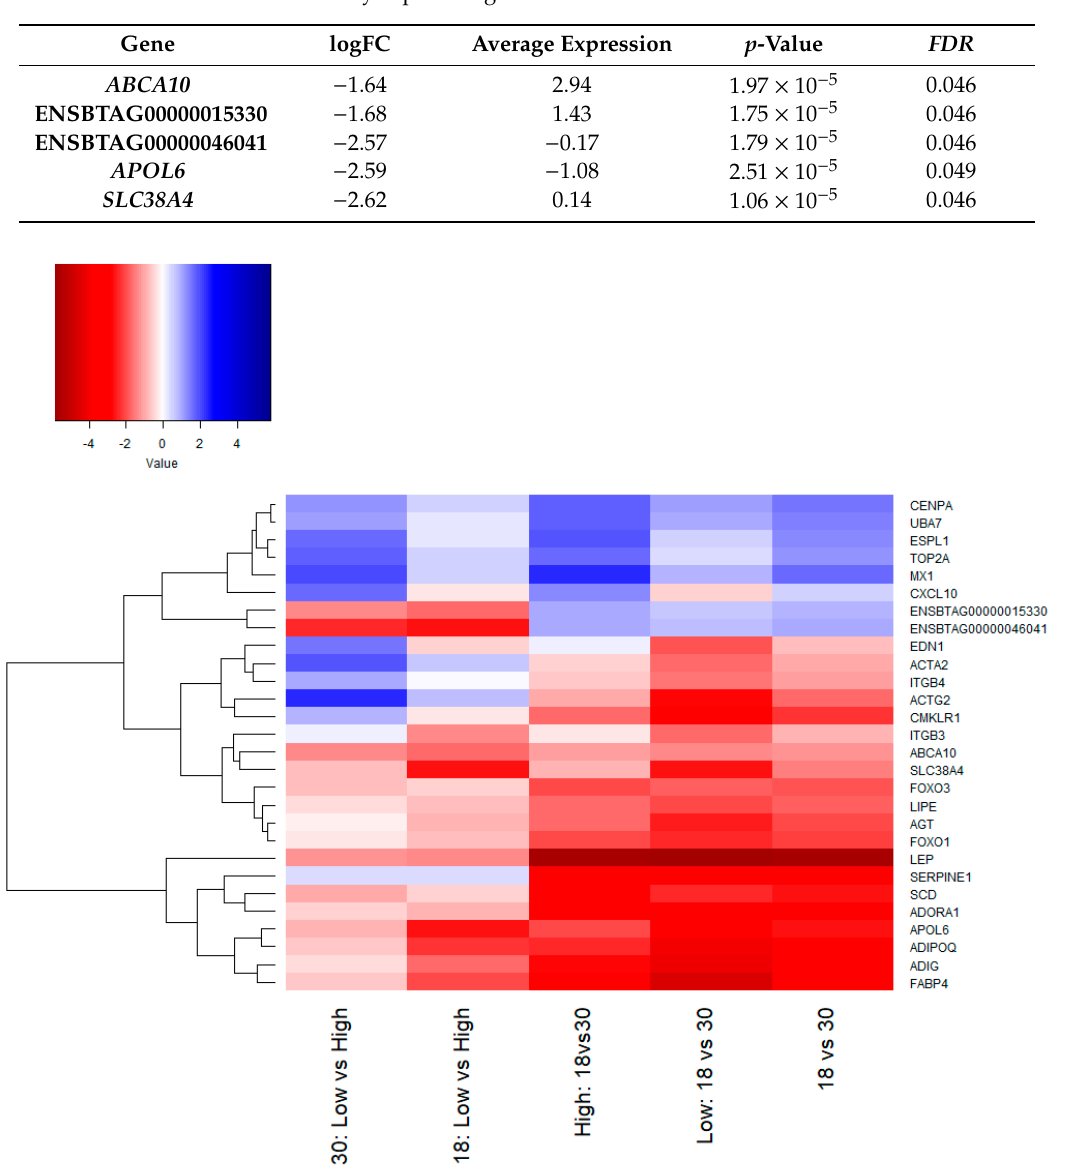
Table 2. Di ff erentially expressed genes in Hanwoo steers at 18 months old.